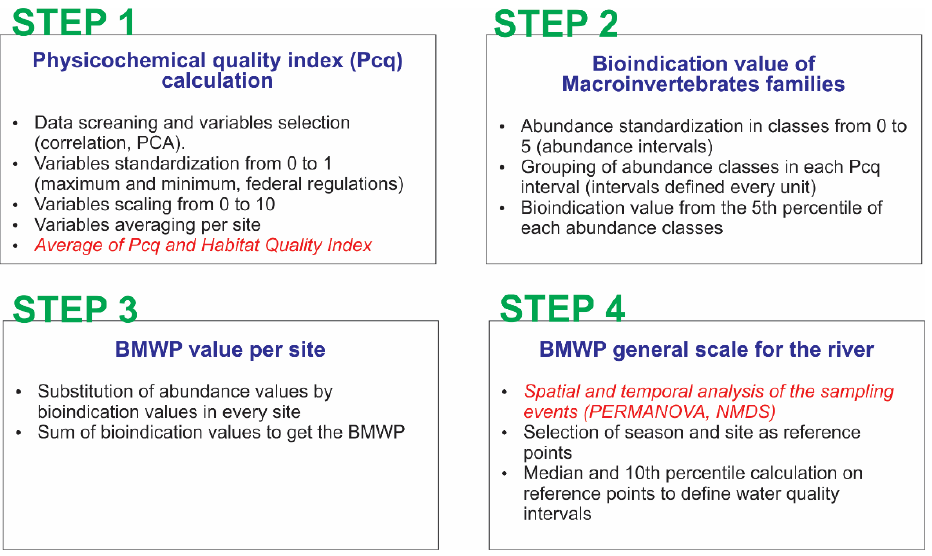
Figure 2. BMWP calibration protocol adapted from Ruiz-Picos et al. [13]. In red and italics, the modification implemented in the present study.